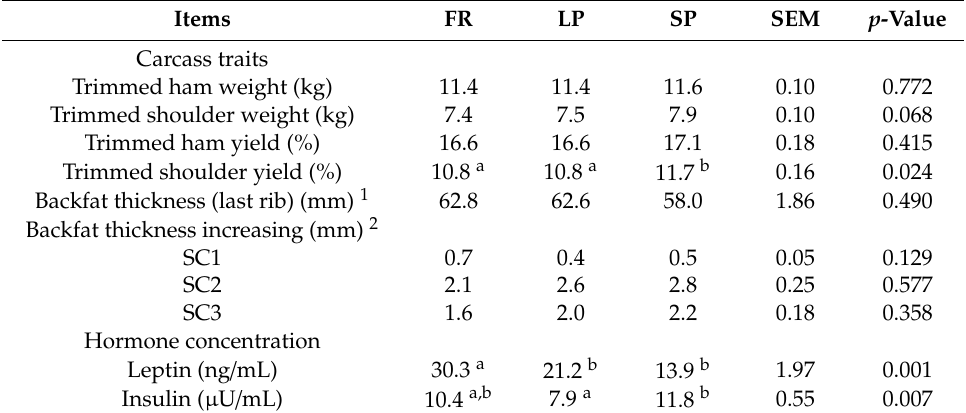
Carcass traits and plasma hormone concentrations from Iberian pigs fed with the experimental